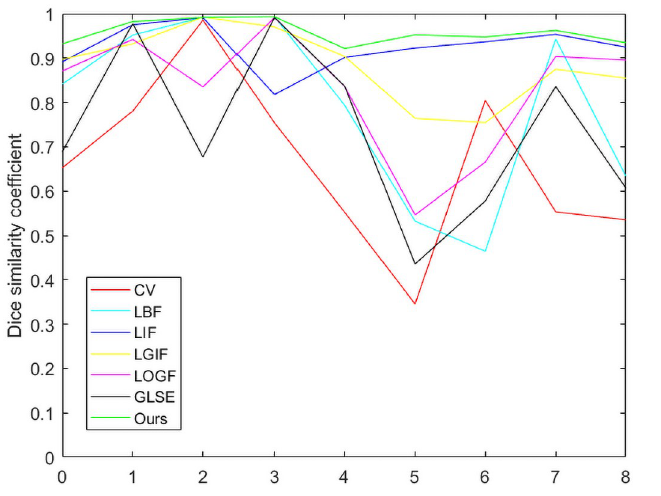
Fig 13. Comparison of various models in terms the DSC